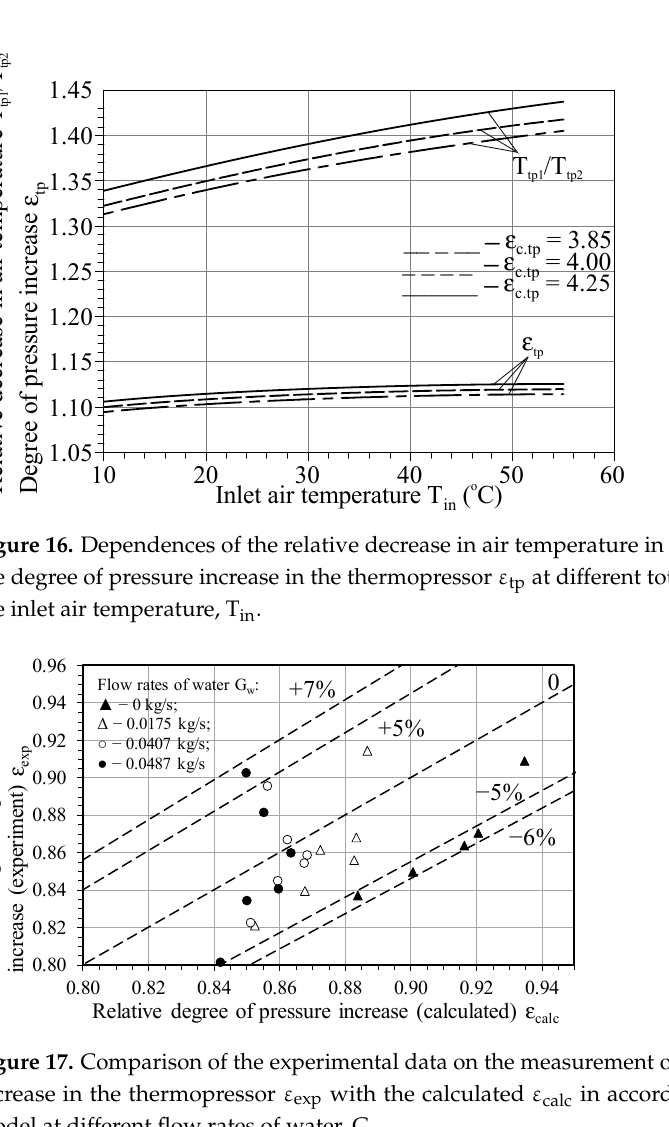
Figure 15. Dependences of the decrease in the thermopressor air temperature, Δ T tp ; an increase in the air pressure at the discharge with “ideal” compression, ΔР tp ', and with real compression, ΔР tp , at different total pressure increase, ε c . tp , on the inlet air temperature, T in .